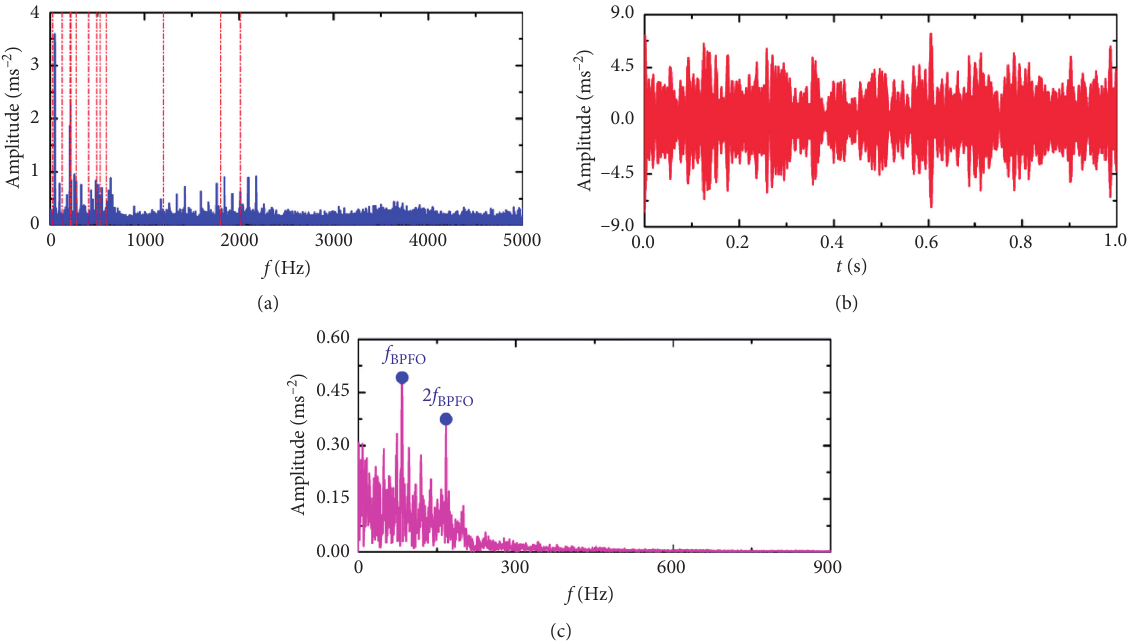
Figure 16: Results obtained by EWT: (a) detected boundaries of Fourier spectrum, (b) the 13th subband signal, and (c) Hilbert envelope spectrum of signal in